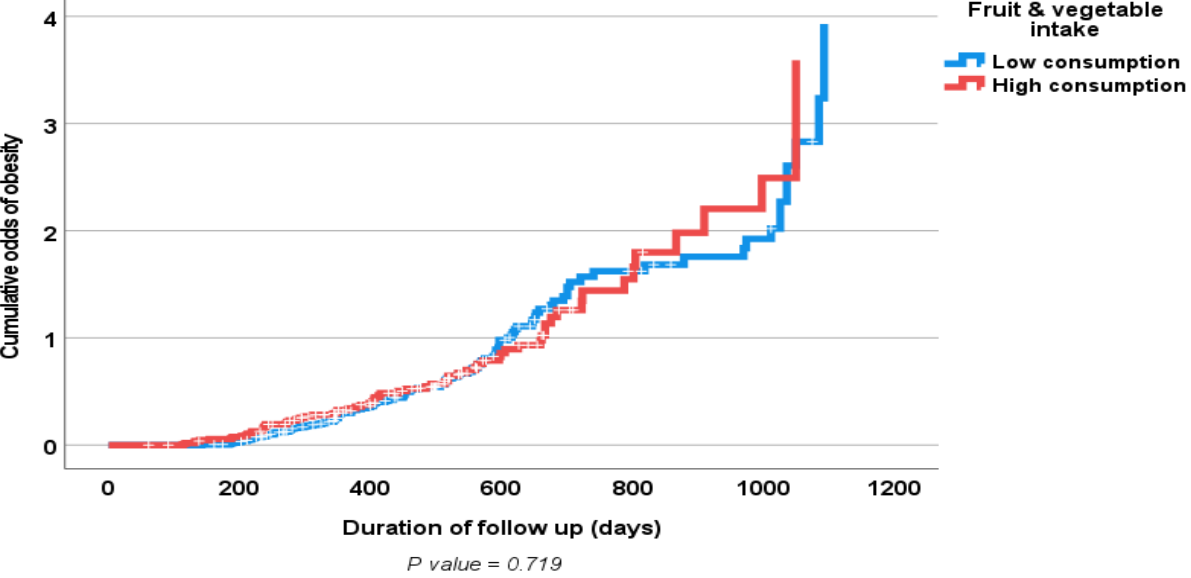
Figure 3. Kaplan–Meier curve of odds of obesity diagnosis according to the fruit and vegetable consumption quartiles at follow up.